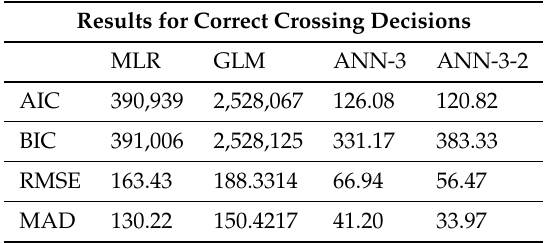
Table 2. Comparison of goodness of fit of MLR, GLM, ANN models with one hidden layer and with two hidden layers to the numbers of ICDs at the simulation end, measured by AIC, BIC, RMSE, MAD.